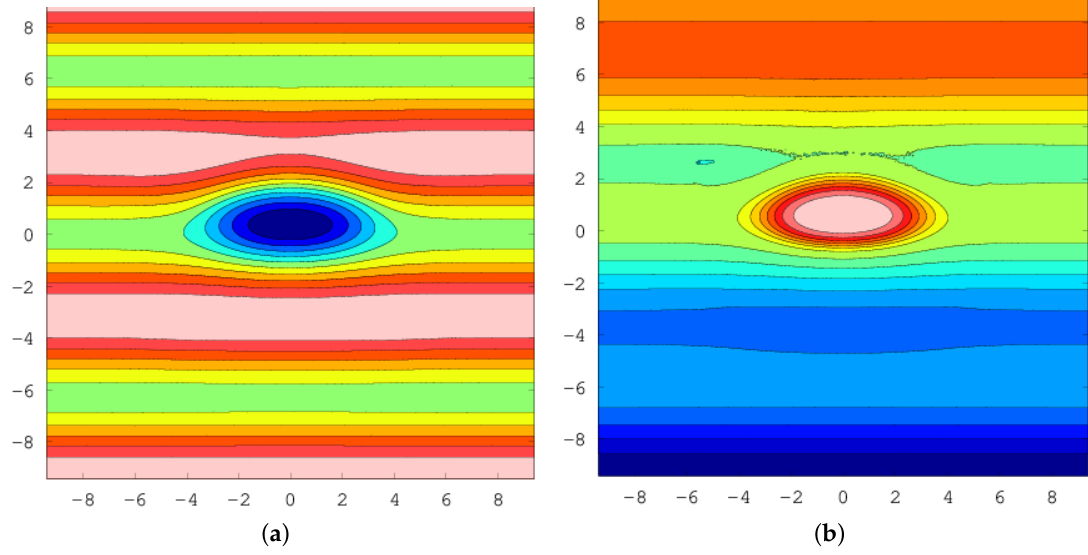
Figure 7. ( a ) Streamfunction for a vortex centered at y = 1. The translation speed is c = − 0.5 = − β . The vortex is offset in x because it has been allowed to propagate freely for 120 time units. ( b ) Potential vorticity for a vortex centered at y = 1. The translation speed is c = − 0.5 = − β